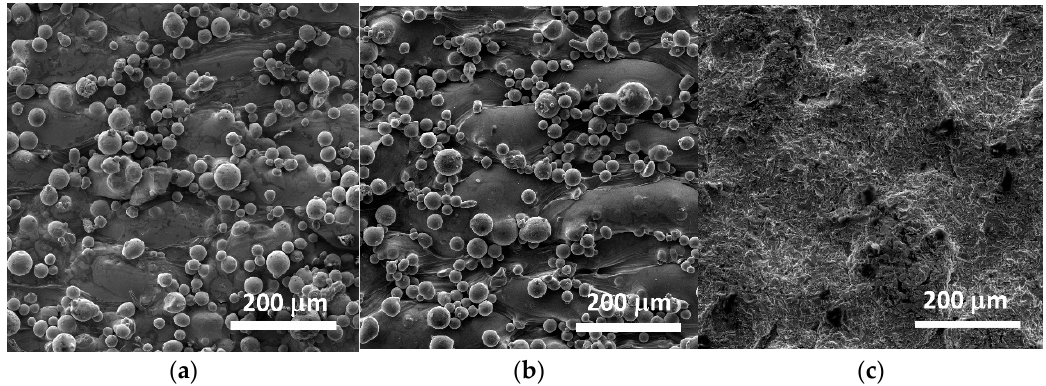
Figure 4. SEM images of the CL20ES specimen surface ( a ) Sample 1; ( b ) Sample 2 and ( c ) Sample 3.